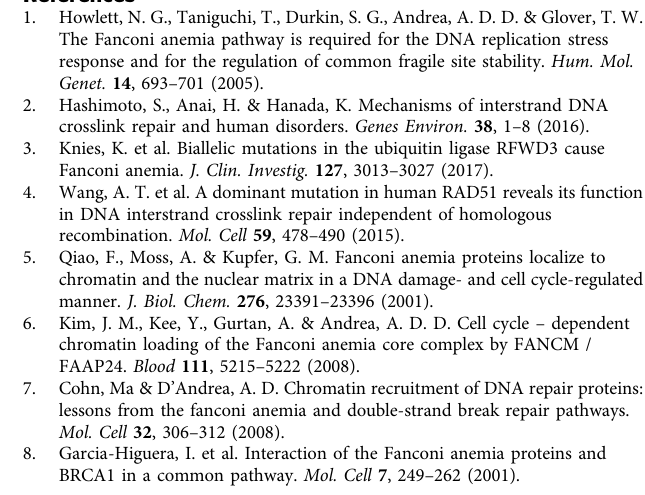
Fig. 4 Role of UAF1 and RAD51AP1 in FANCD2 deubiquitination in cells. a HeLa cells depleted for endogenous UAF1 and stably expressing UAF1 (WT), UAF1 3A (3A), or UAF1 11A (11A) were examined for their level of ubiquitinated FANCD2 by western blotting. Ku86 was included as the loading control. b Survival of cells (from a ) upon treatment with MMC or olaparib. The error bars represent mean values±S.D. of data from three independent experiments. c RAD51AP1 knockout HeLa cells depleted for endogenous UAF1 and stably expressing WT or mutant UAF1 with or without the co-expression of either RAD51AP1 (AP1) or the RAD51AP1 DM (DM) mutant were examined for their level of ubiquitinated FANCD2. Ku86 was included as the loading control. The error bars represent the mean + S.D. of data from three independent experiments. d Survival of cells (from c ) upon treatment with MMC. The error bars represent mean values±S.D. of data from three independent experiments. e Model for the role of the USP1-UAF1-RAD51AP1 complex in the FA pathway. Mono-ubiquitination and deubiquitination of FANCD2 both occur on DNA. DNA binding by either UAF1 or RAD51AP1 is suf fi cient for targeting the trimeric DUB complex to DNA bound,